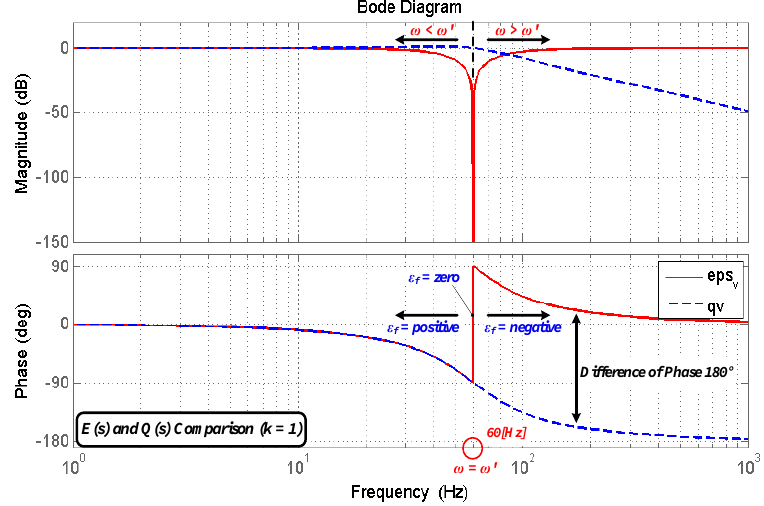
Figure 11. Comparison of transfer functions E ( s ) and Q ( s ) .